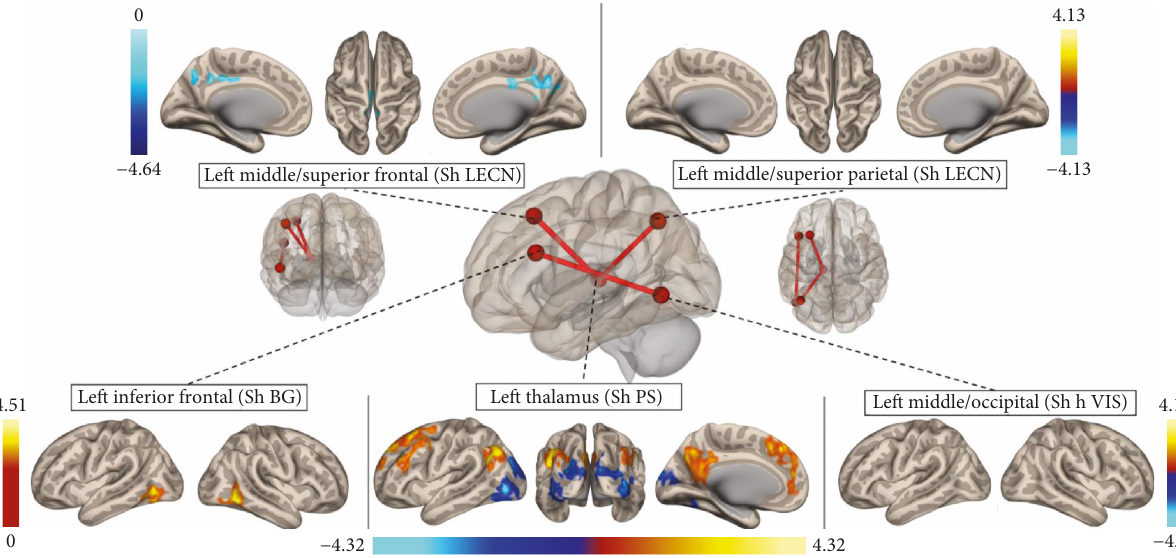
Figure 6: Most representative measure of the Power component explained by resting state functional connectivity. ROI-to-ROI analysis reveals a hyperconnectivity in the left inferior frontal-left superior occipital and left superior frontal-left thalamus-left superior parietal connections. Seed-to-voxel results, thresholded (FDR corrected), are shown for each of the 5 nodes. Unthresholded pattern activation is shown in Figure S4 supplementary materials. All voxels with signi fi cant connectivity changes are shown in the fi gure and listed in Table S3, Supplementary materials. Note: H-O: Harvard-Oxford; Sh LECN: Shirer left executive control network; Sh BG: Shirer basal ganglia; Sh PS: Shirer posterior salience; Sh h VIS: Shirer higher visual.